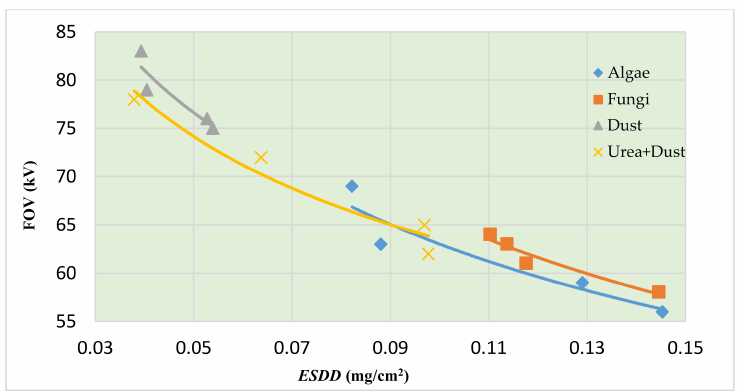
Figure 4. ESDD vs. FOV characteristics of the insulator contaminated with partially soluble biological and agricultural